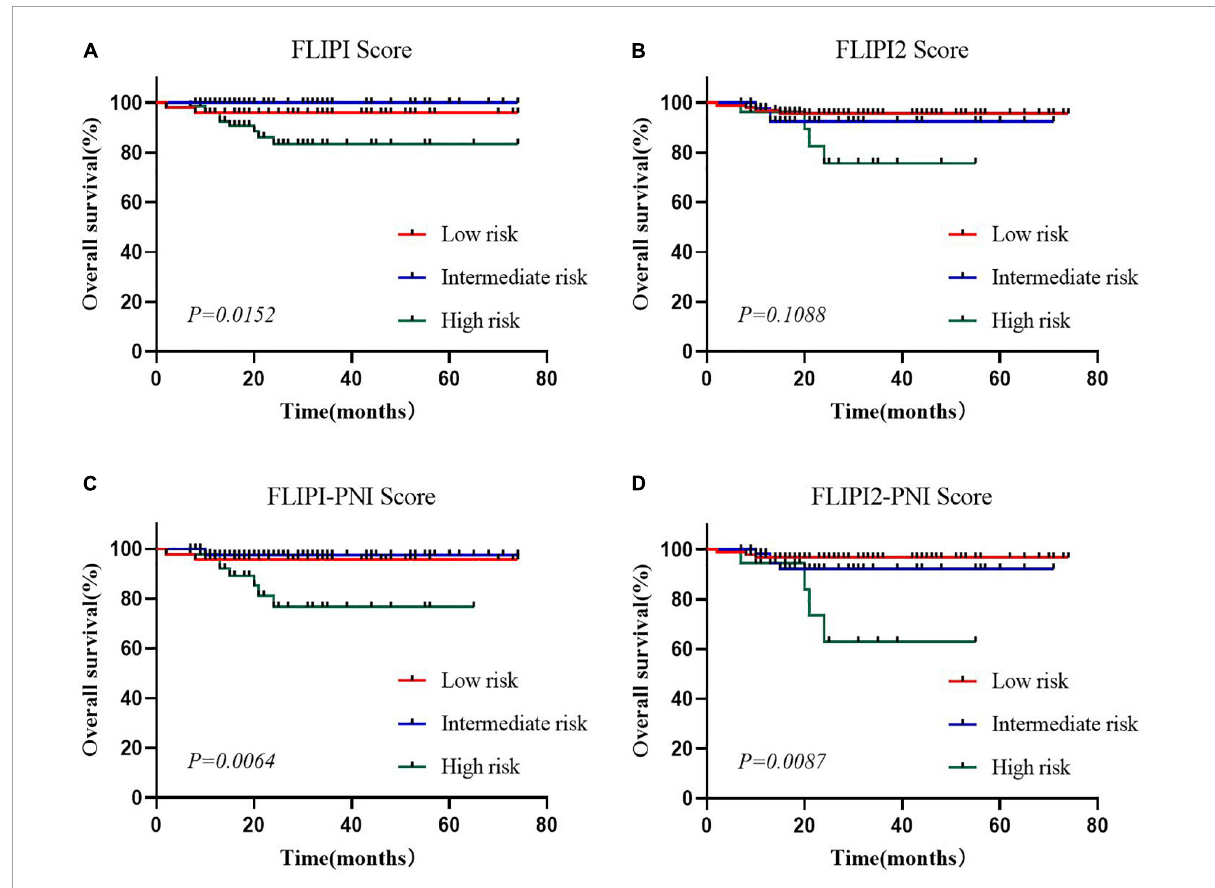
FIGURE4 Overall survival for risk groups defined by four scoring systems. (A) FLIPI, (B) FLIPI2, (C) FLIPI-PNI, (D) FLIPI2-PNI.